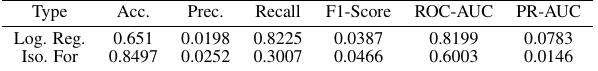
Table 5. Results for baseline